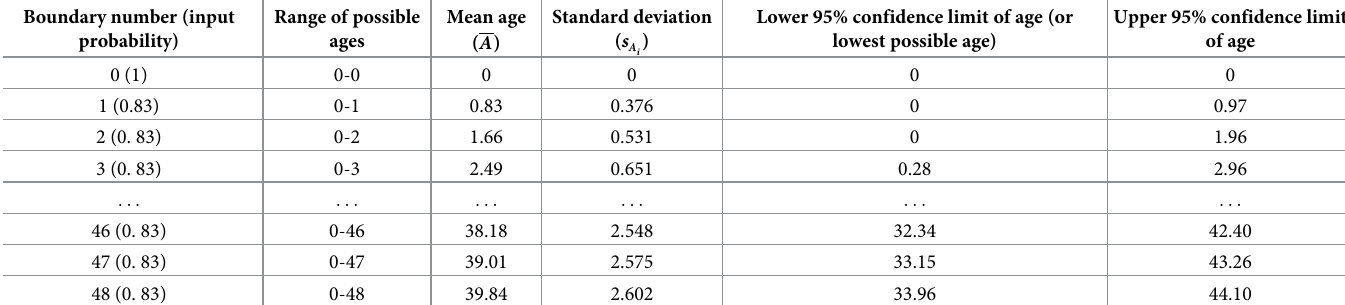
Table 5. Statistics of age assignment for a subset of the ring boundaries from Fig 2. Boundary number (input